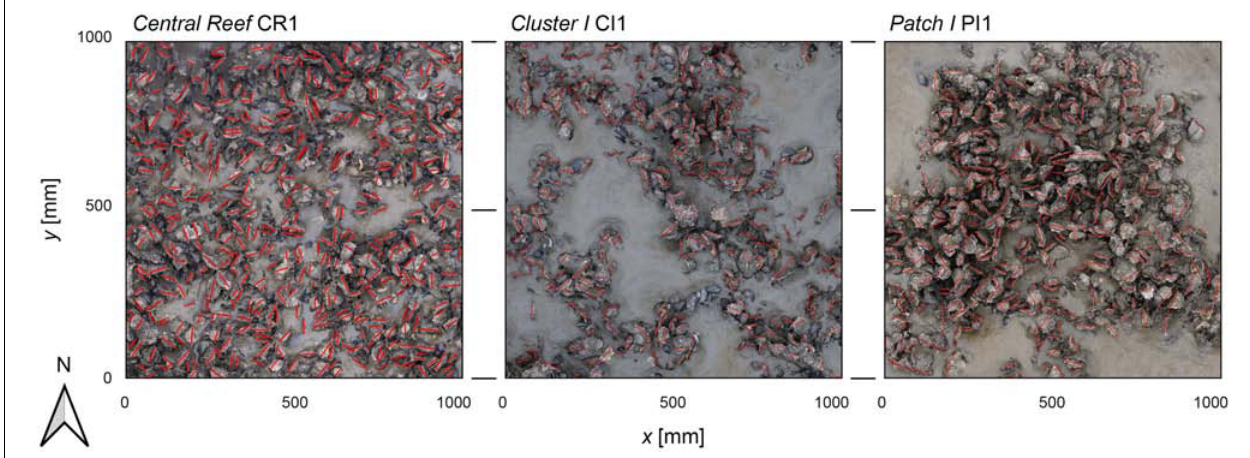
FIGURE 6 | Three examples of the orthomosaics used to derive the abundance and the dorso-ventral orientation. The x - and y- axis are in mm. Red lines mark the short axis of the identified individual oyster shells. The panels show the samples of Central Reef CR1, Cluster I CI1, and Patch I PI1. Each photo covers 1 m 2 with the upper side facing